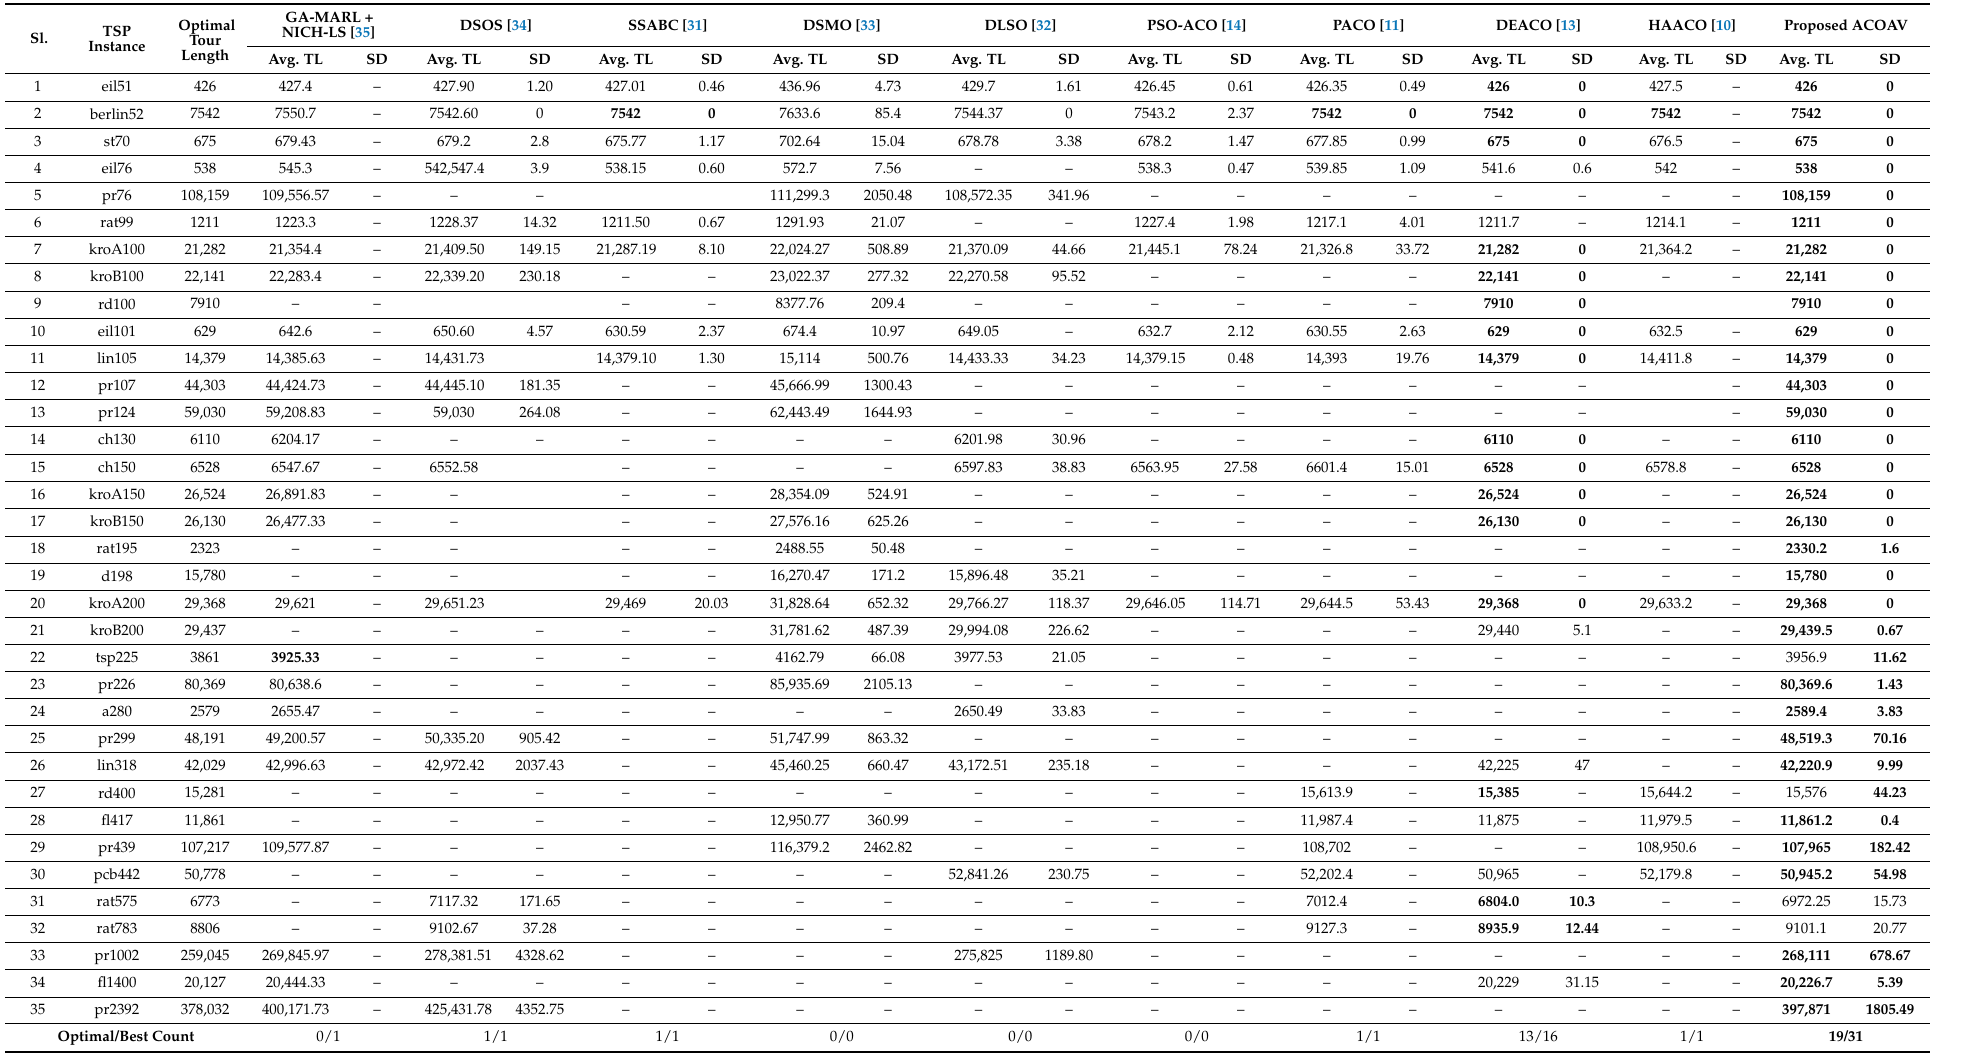
Table 3. Average Tour Length (TL) and Standard Deviation (SD) Comparison of ACOAV with Existing State-of-the-Art Bio-inspired Methods.